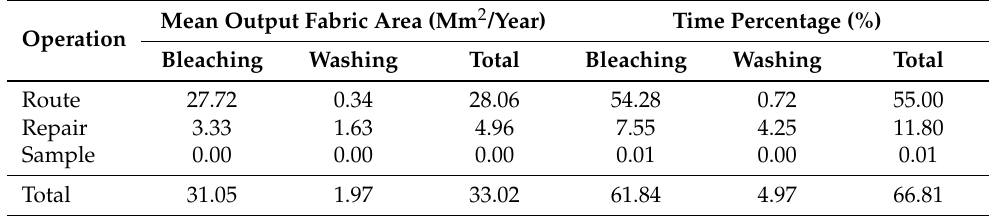
Table 15. Production metrics (2020–2021) for the bleaching machine (ZORLUTEKS).